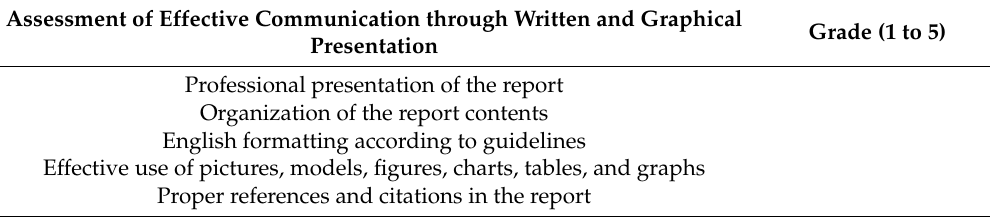
Table 9. Skills evaluation criteria in the report and